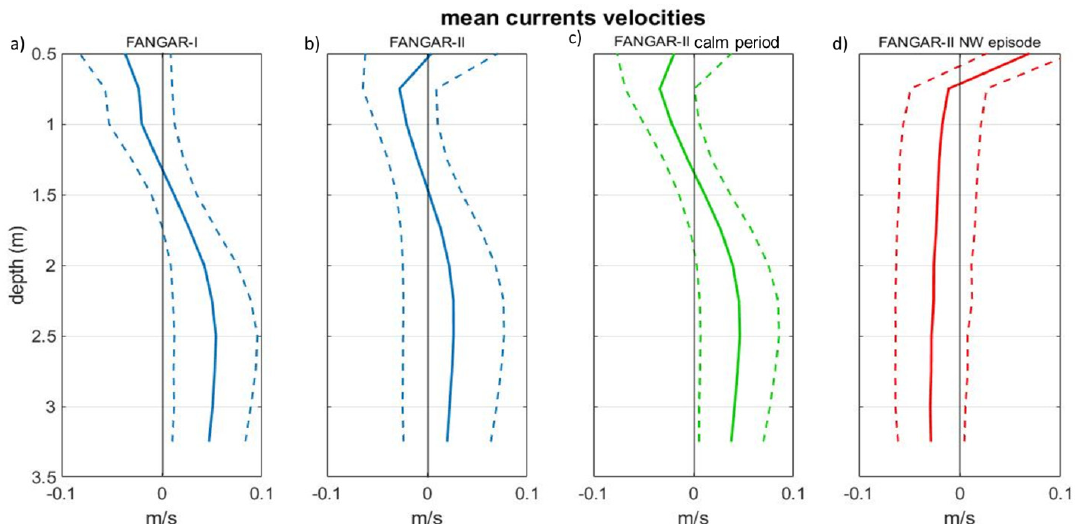
Figure 6. Average alongshore current velocity (positive outward) profile (continuous line) and standard deviation (dashed lines) for the mouth in FANGAR-I ( a ) and in FANGAR-II ( b ); ( c , d ) show the mean profile during FANGAR-II for the calm period ( c ) and the NW wind period ( d ).